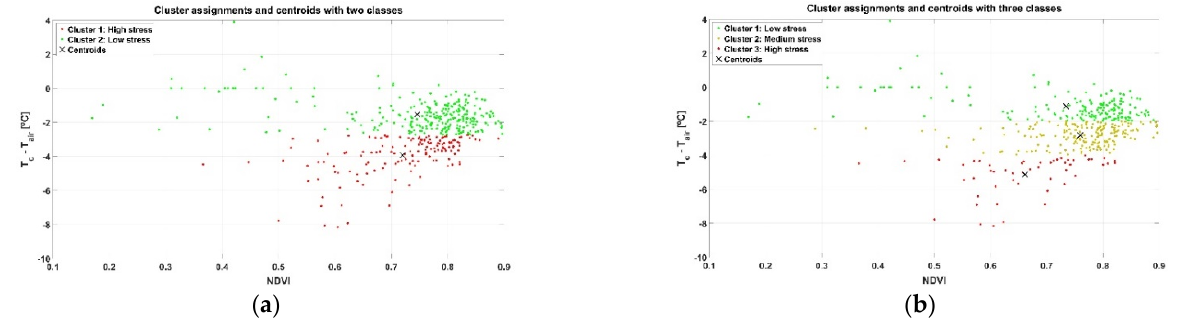
Figure 10. Clustering results and centroids for Map A: ( a ) two classes (k = 2); and ( b ) three classes (k = 3).